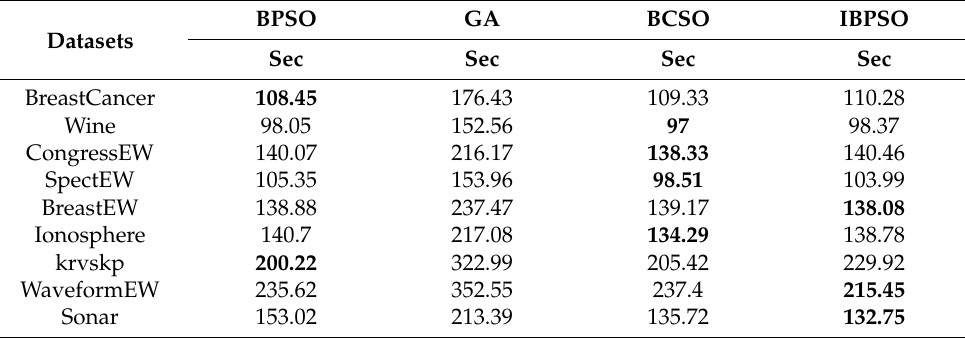
Table 5. Comparison between IBPSO based on average computational